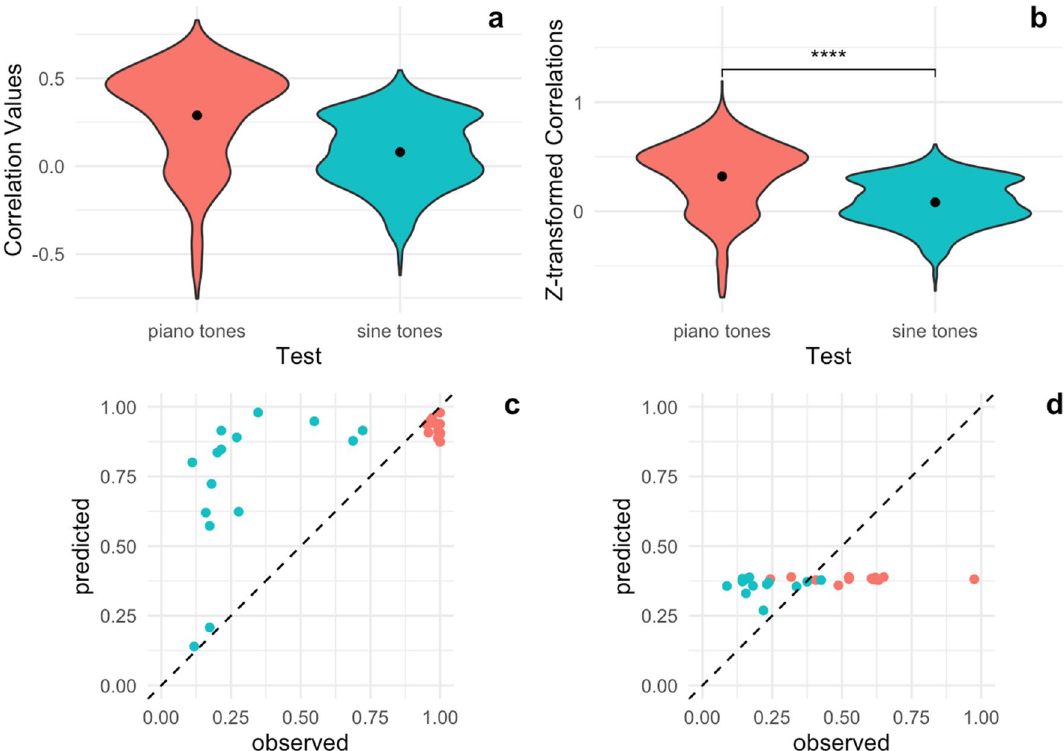
Figure 4. Predictive Performance of Piano FFR on Sine Tones and Piano Tones separately. ( a , b ) Correlation between the predicted pitch labelling performances and the true pitch labelling performances on a test set are shown for 1000 cross-validation runs. The FFR to the piano tone predicts pitch labelling performance for piano tones better than it does for sine tones. ( c ) Predicted pitch labelling performance on the piano tones plotted against actual, observed pitch labelling performance. Red dots represent subjects who self-reported as AP possessors. ( d ) Predicted pitch labelling performance on the sine tones plotted against observed pitch labelling performance. Red dots represent subjects who self-reported as AP